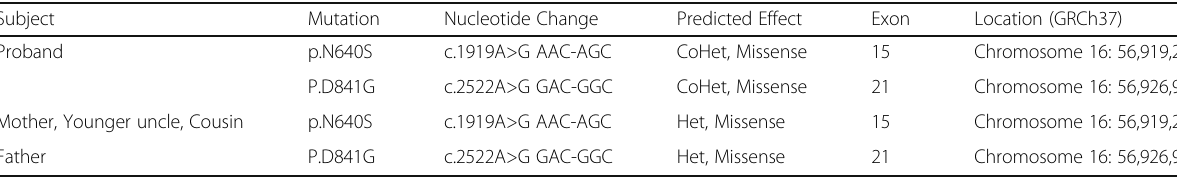
Table 2 Summary of SLC12A3